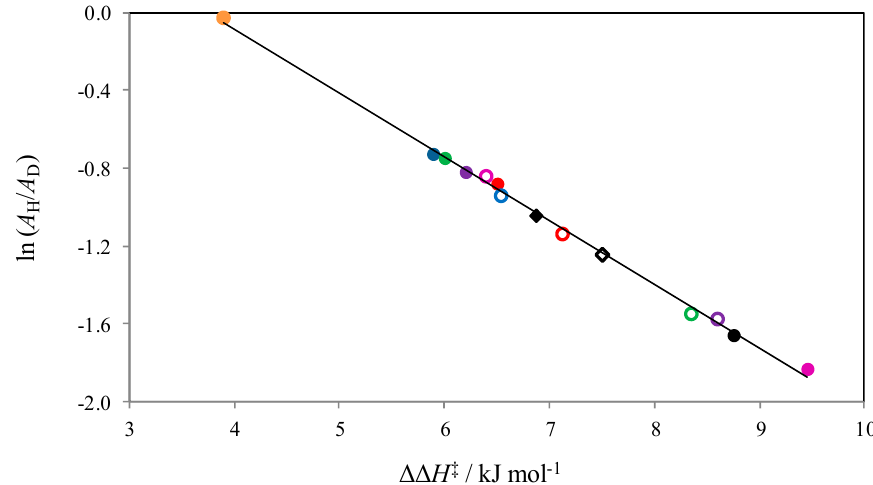
Figure 5. Correlation between ΔΔ H ‡ (D,H) and ln A H / A D . Key: orange circle, neat water [35]; violet circle, 0.005 M TMACl; blue circle, 0.01 M TEACl; magenta circle, 0.1 M TEACl; red circle, 0.005 M TPACl; green circle, 0.005 M TBACl; black circle, 0.1 M BTMACl; hollow black diamond, 0.1 M AChCl; black diamond, 0.006 PQCl 2 ; hollow blue circle, 1,4-dioxane:water = 0.05:0.95 v / v ; hollow green circle, 1,4-dioxane:water = 0.1:0.9 v / v ; hollow red circle, MeCN:water = 0.05:0.95 v / v ; hollow violet circle, MeCN:water = 0.1:0.9 v / v ; hollow magenta circle, EtOH:water = 0.1:0.9 v / v . Abbreviations as noted in